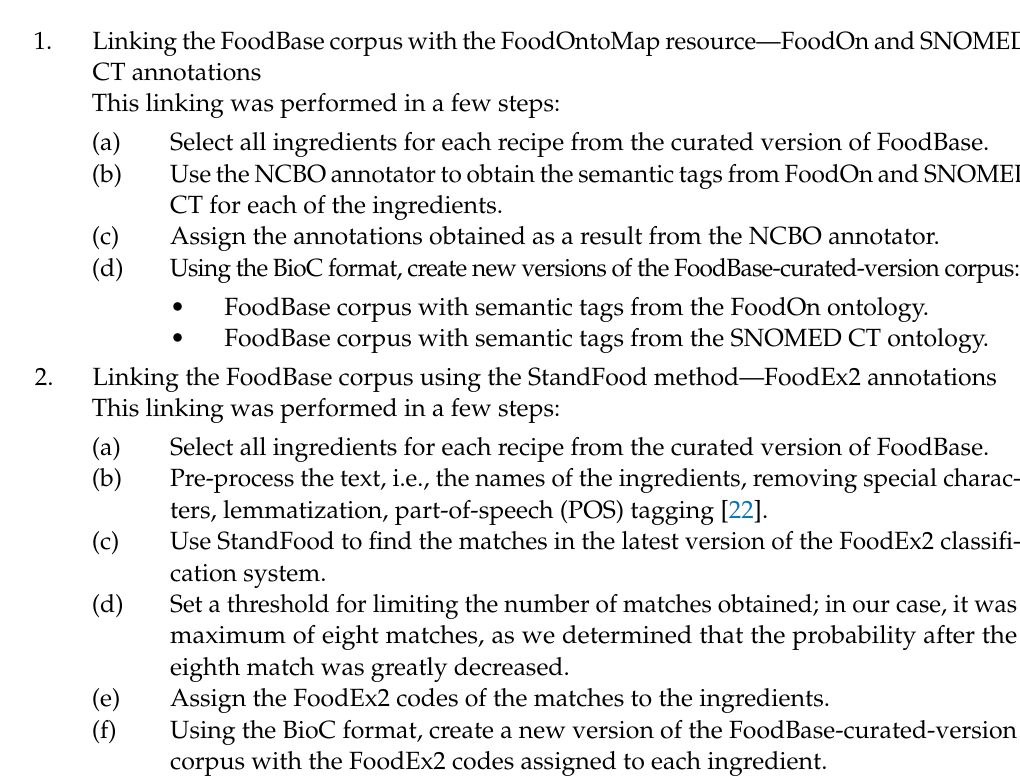
Figure 2. Flowchart of the